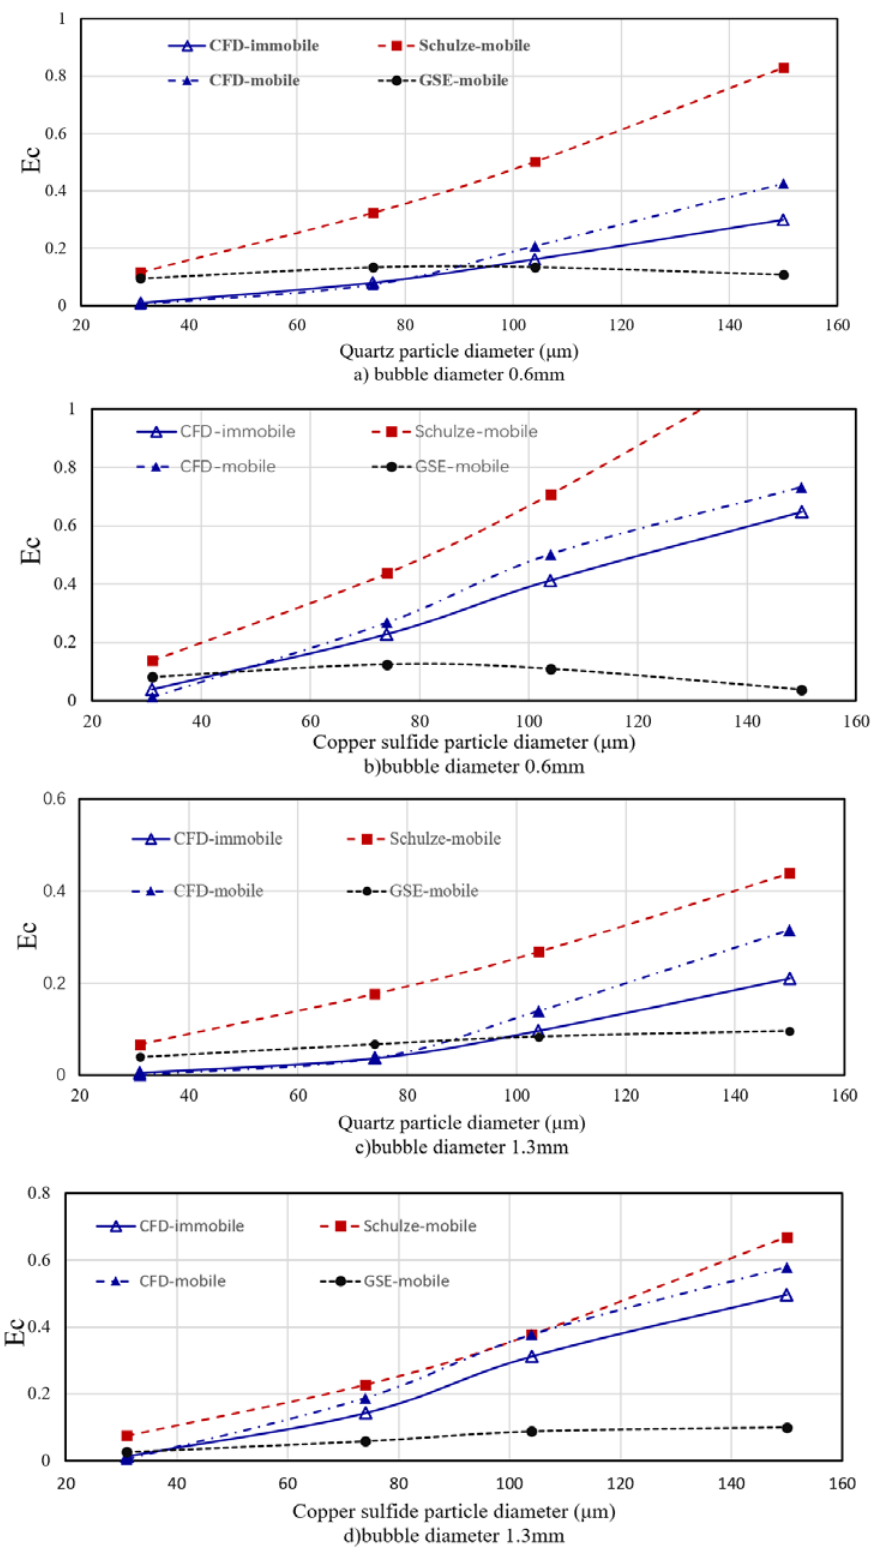
Figure 11. Comparison of Schulze, GSE, and CFD simulation models for collision efficiency for bubble diameters of 0.6 mm ( a , b ) and 1.3 mm ( c , d ), and particle densities of 2650 kg/m 3 (a,c) and 5600 kg/m 3 (b, d).